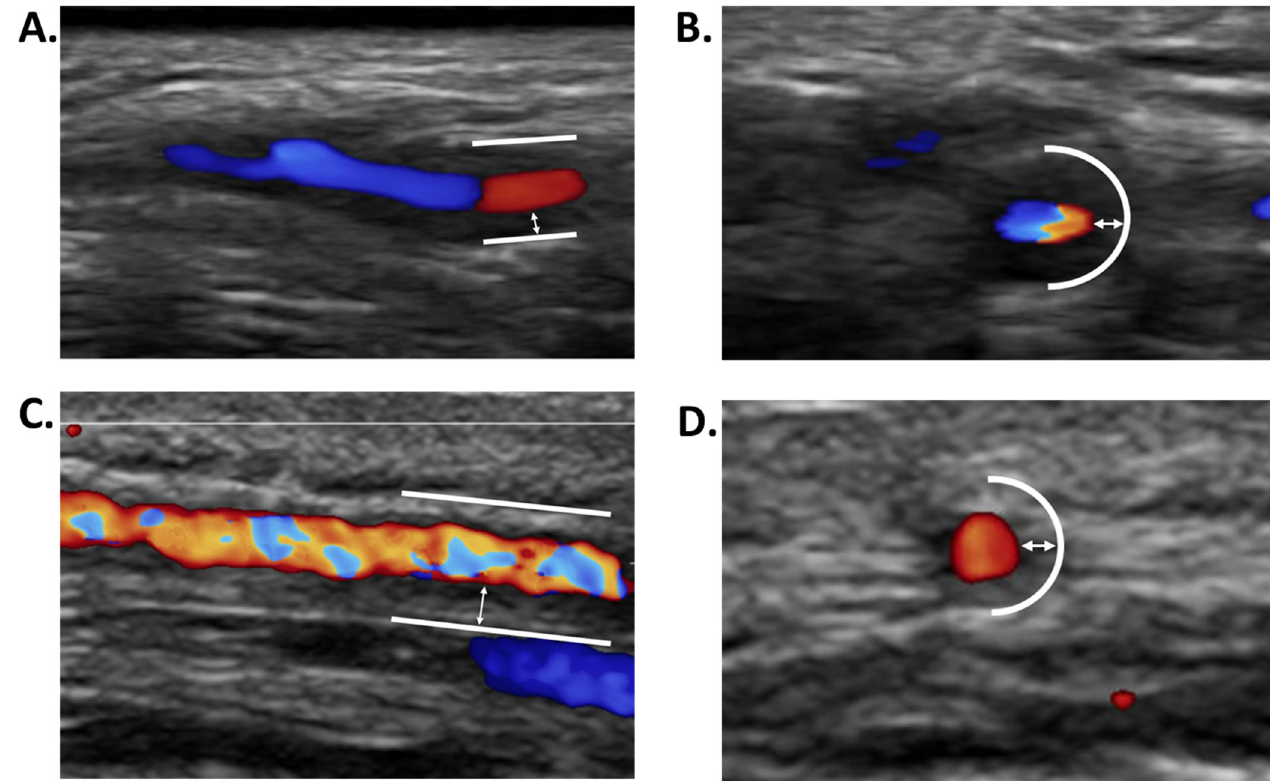
Figure 2. ( A , B ): True halo sign: hypoechoic parietal thickening of the temporal artery wall on Doppler ultrasound in a patient with GCA, in longitudinal ( A ) and transverse ( B ) sections; ( C , D ): iso/hyperechogenic parietal thickening of the temporal artery wall related to atherosclerosis, in longitudinal ( C ) and transverse ( D ) sections. The solid line shows the adventitia (hyperechoic), the double arrow shows the intima-media thickness, the arterial lumen is colored.